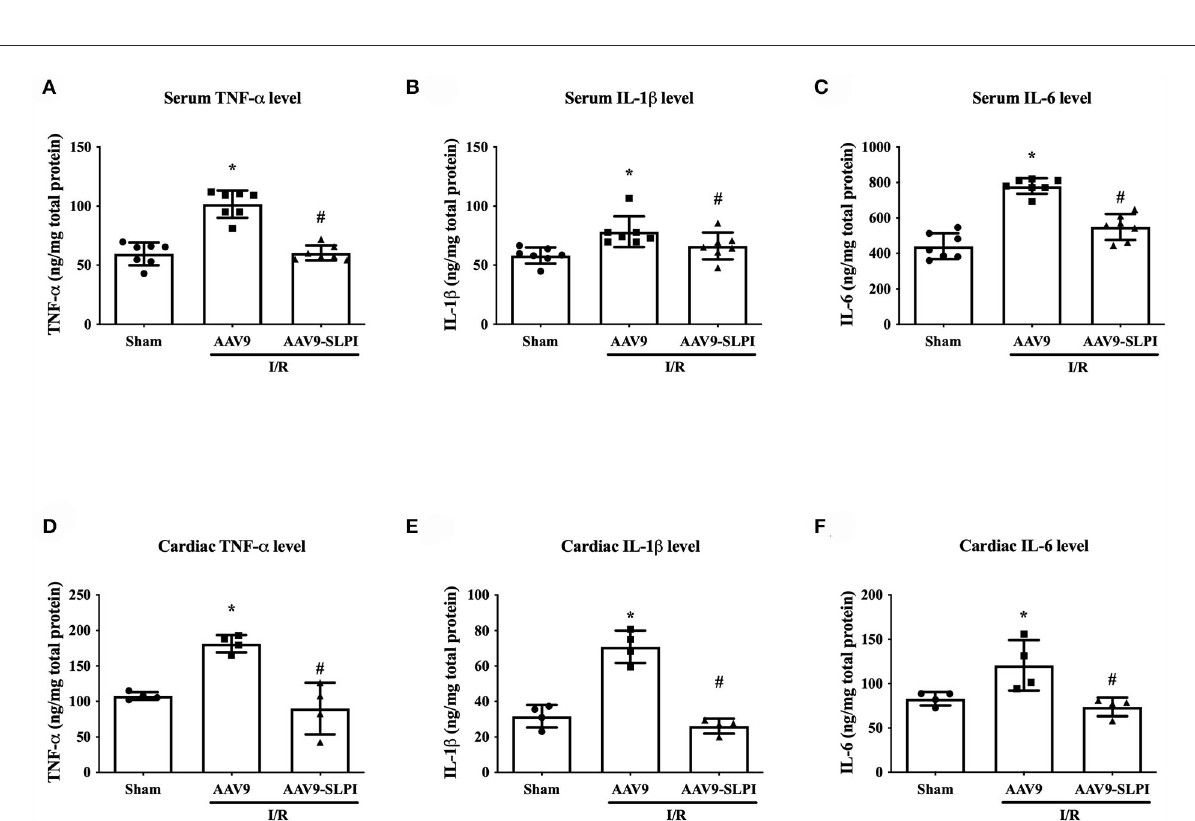
FIGURE4 Determination of inflammatory cytokines after treating with viral particles including serum TNF- α level (A) , IL-1 β level (B) , IL-6 (C) , and cardiac TNF- α level (D) , IL-1 β level (E) , and IL-6 (F) on I/R injury rats (* p < 0.05 vs. sham) ( # p < 0.05 vs.